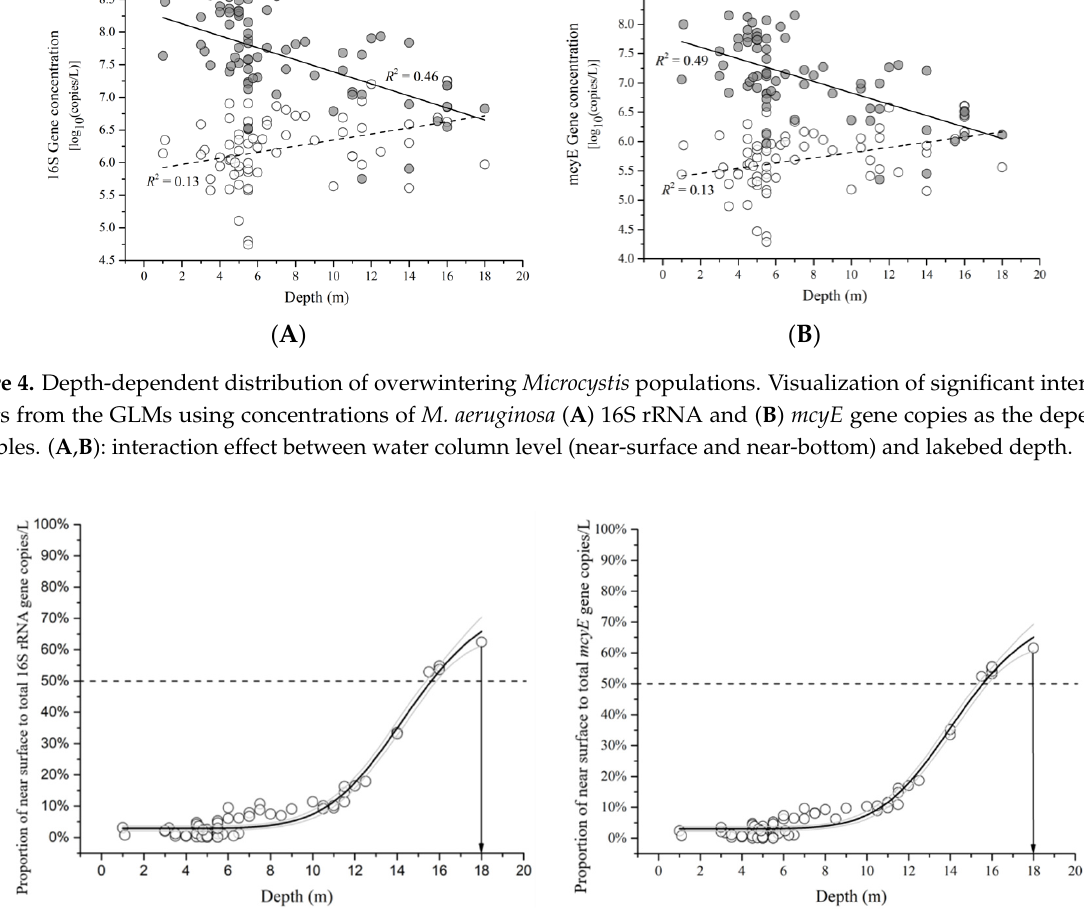
Figure 4. Depth-dependent distribution of overwintering Microcystis populations. Visualization of significant interaction effects from the GLMs using concentrations of M. aeruginosa ( A ) 16S rRNA and ( B ) mcyE gene copies as the dependent variables. ( A , B ): interaction effect between water column level (near-surface and near-bottom) and lakebed depth.